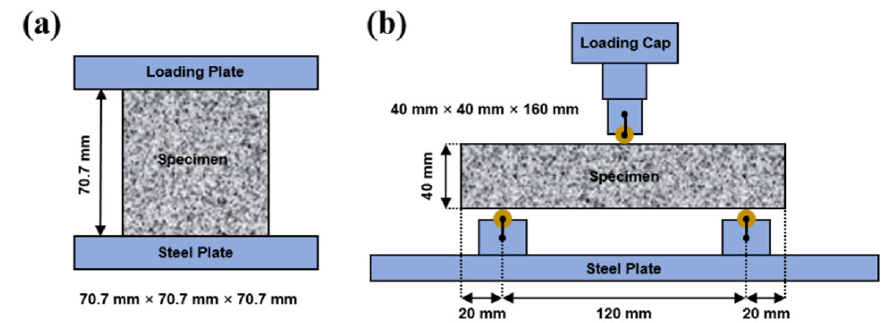
Figure 2. Schematics of the tests for compressive ( a ) and flexural ( b ) strengths.